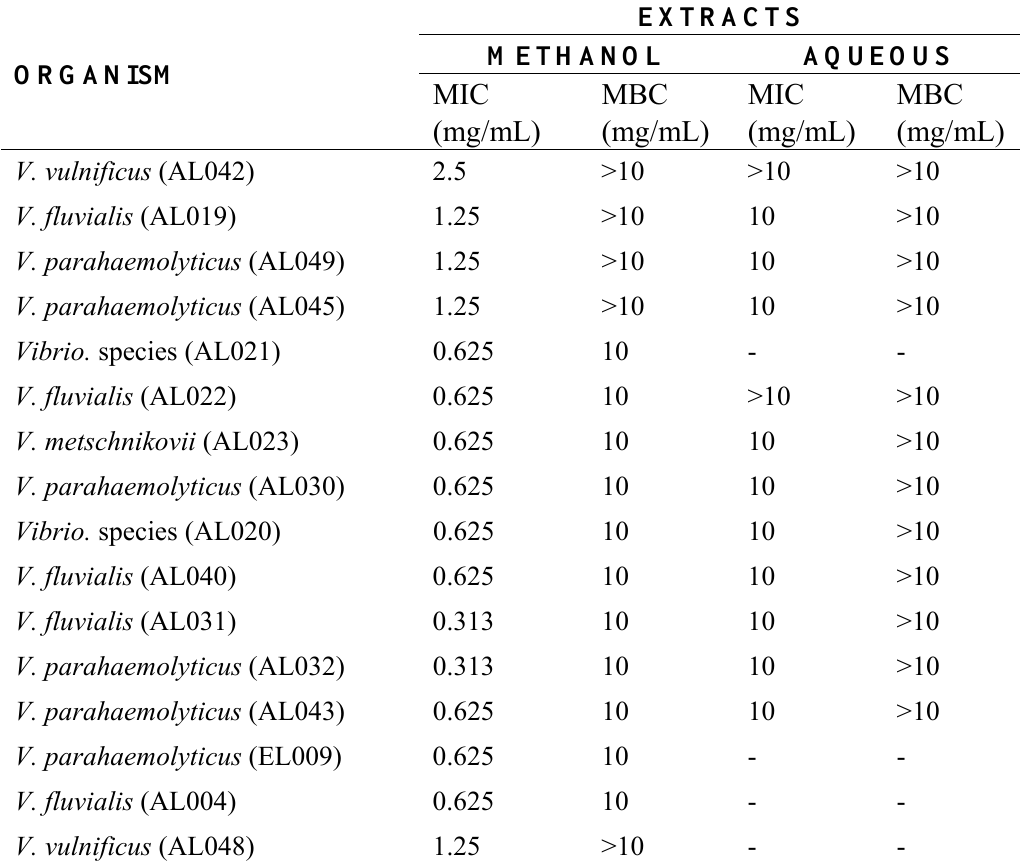
Table 2. Minimum inhibitory concentrations (MIC) and minimum bactericidal concentrations (MBC) of the methanol and aqueous extracts against the susceptible Vibrio isolates.